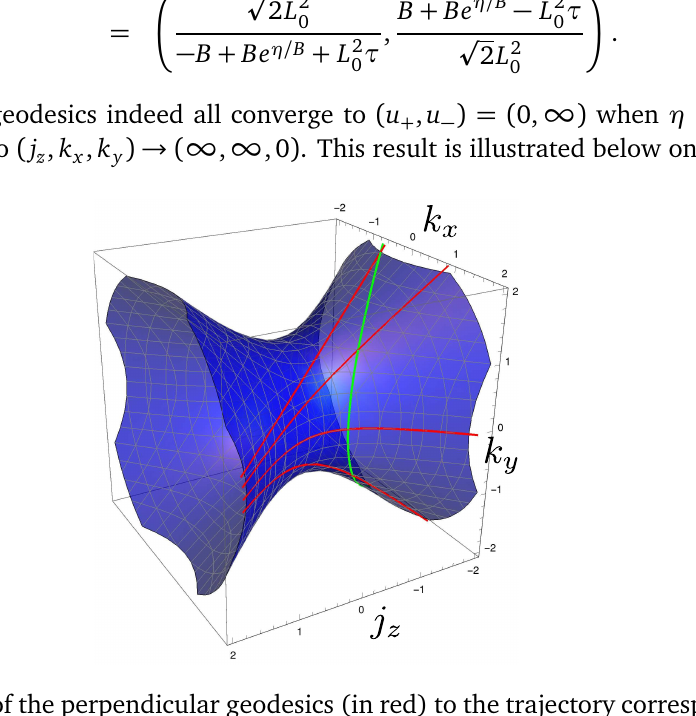
Figure 3: Plot of the perpendicular geodesics (in red) to the trajectory corresponding = 1 (in green) for a Casimir value of B = 1. We see that the geodesics converge to L 0 ) → ( ∞ , ∞ ,0 ) as ( j , k , k z x y